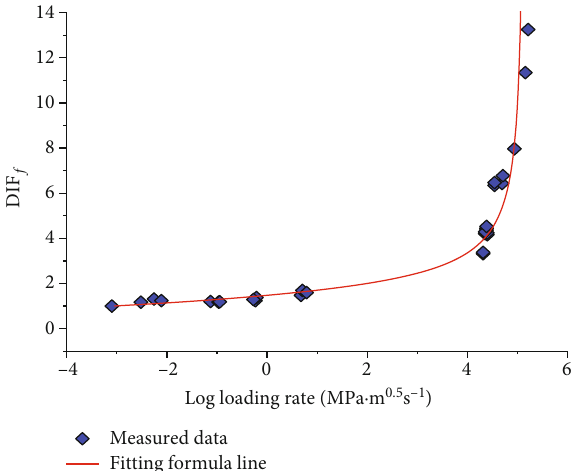
Figure 8: Variation in the rock fracture toughness at low to high loading